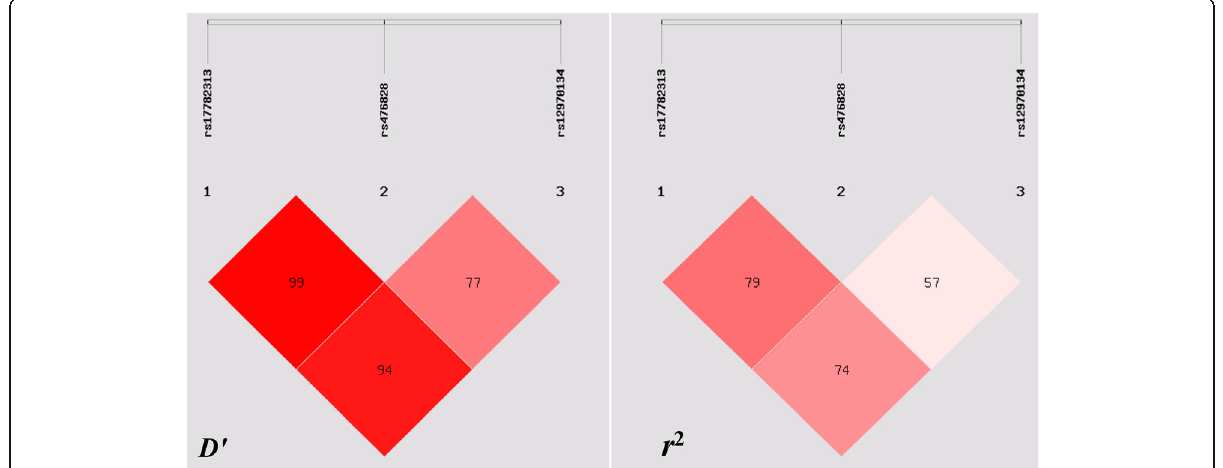
Fig. 1 Linkage disequilibrium (LD) analysis of the MC4R SNPs in both populations. The LD degree was represented by pair-wise D ’ and r